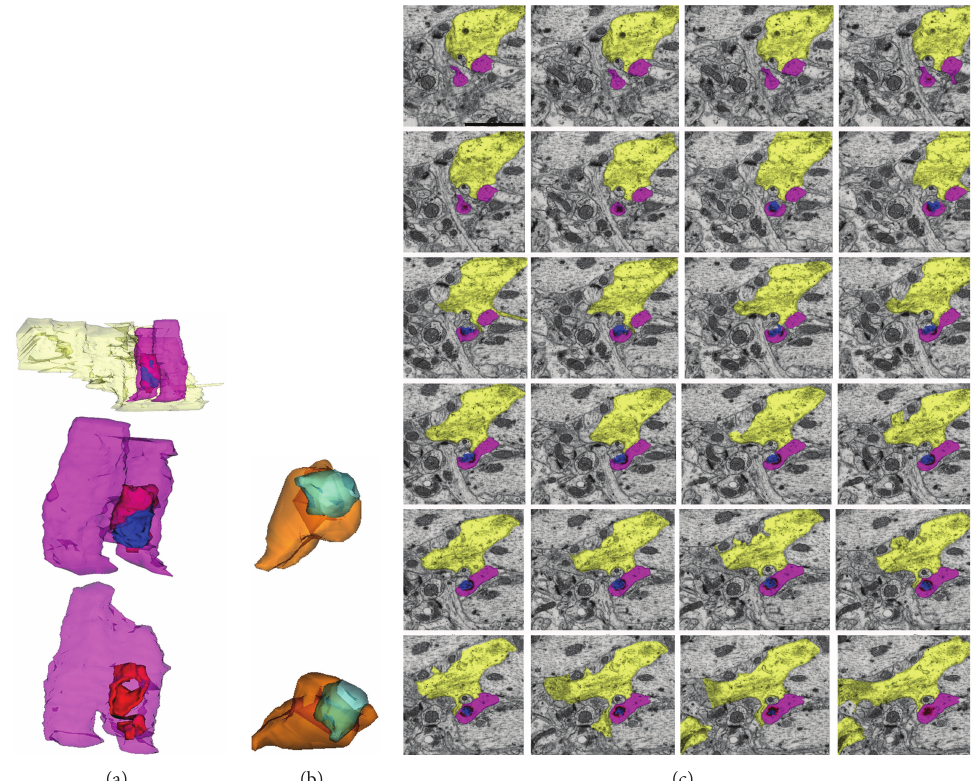
Figure 5: Three-dimensional reconstructions of degenerating synapses in the stratum radiatum of hippocampus in prion disease. (a) Rotations of a synaptic profile generated from 46 consecutive sections; the material originating from the presynaptic terminal (in blue) remains outside and inside (engulfed by the PSD (in red)) of the dendritic spine (in purple). Note the presence of one astrocytic process (in yellow) in proximity but not engaged with the degenerating terminal. The first 24 consecutive sections, from which the profile was generated, are illustrated in (c). (b) Rotations of a synaptic profile from 20 consecutive sections. The presynaptic element (in blue) appears internalized by the dendritic spine head (in orange); however, a fine strand of material originating from the presynaptic element remains in association with the extracellular space and is not within the encircling PSD of the spine. (c) Electron micrographs of serial sections illustrating a degenerating synaptic terminal in the stratum radiatum neuropil. The cytoplasm of the presynaptic element (in blue) is electron-dense in all sections; although the synaptic vesicles are still visible, the presynaptic element is disconnected from the projecting axonal terminal and remains arrested and almost completely engulfed by the PSD (in red) of the dendritic spine (in purple). A process of one astrocytic cell (in yellow) is in close proximity. Scale bar: 1000nm. Reproduced from ˇSiˇskov´a et al.